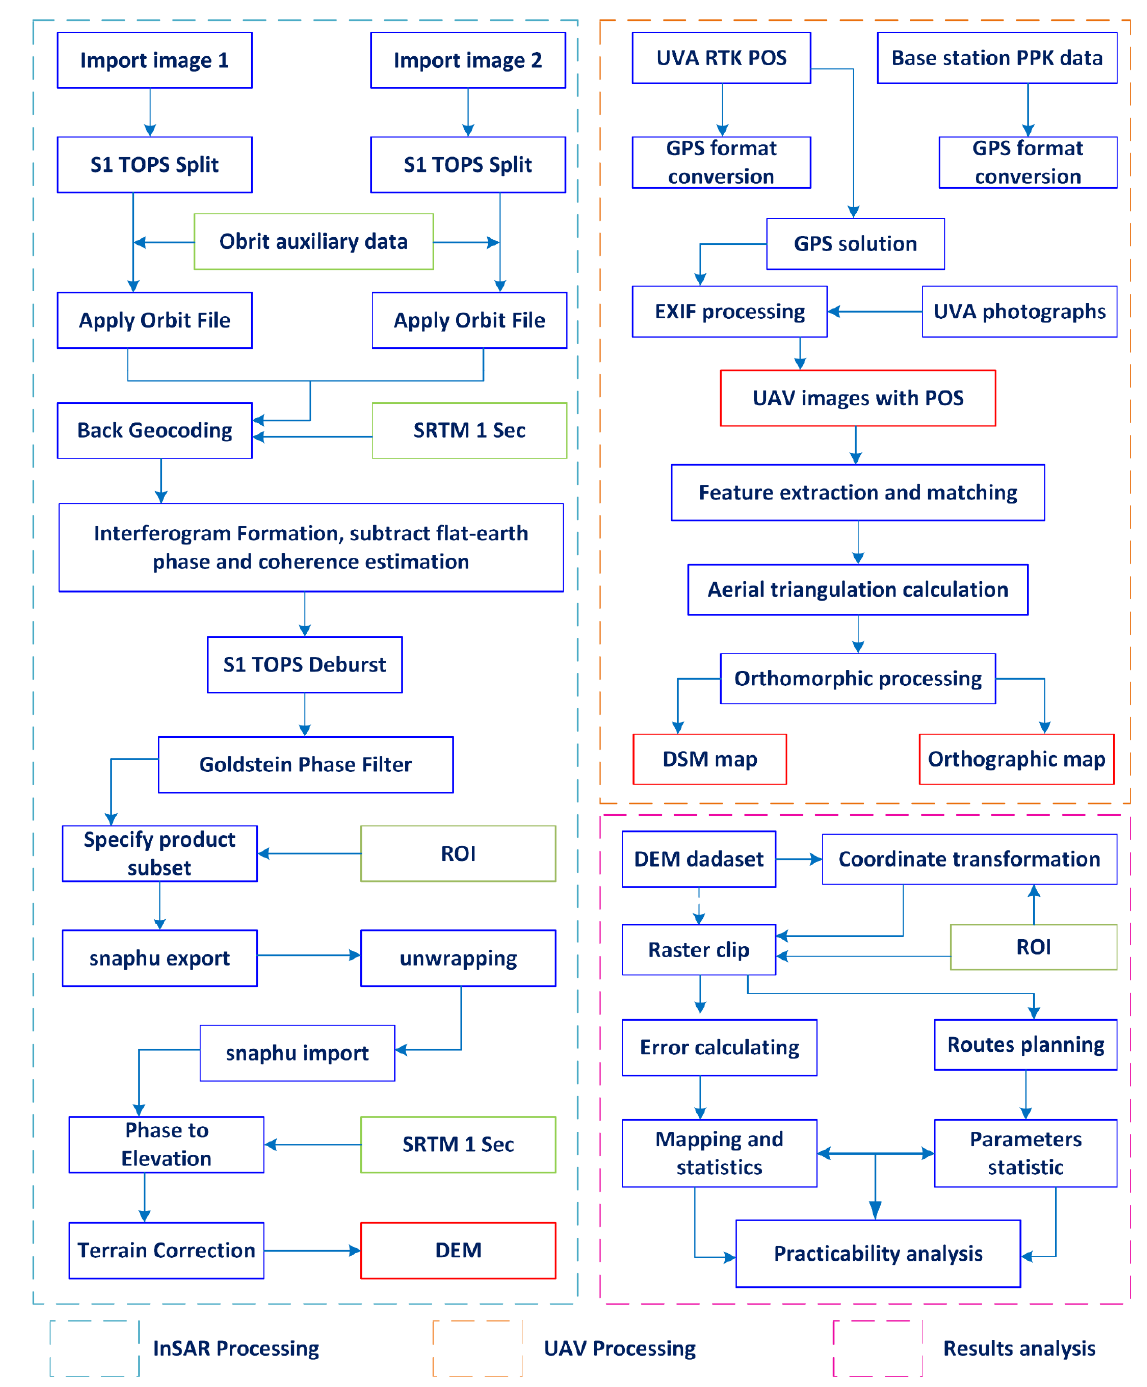
Figure 3. Method flow chart including InSAR processing, UAV image processing, and subsequent data analysis. The tripartite auxiliary data as input are shown in green, and the resulting products are marked with red rectangular boxes. TOPS, terrain observation with progressive scan; SRTM 1 Sec, Shuttle Radar Topography Mission 1-arc Second V3.0 DEM; ROI, region of interest; DEM, digital elevation model; UAV, unmanned aerial vehicle; RTK, real ‐ time kinematic; POS, position and orientation system; PPK, post ‐ processed kinematic; GPS, global positioning system; EXIF, exchangeable image file format; DSM, digital surface model.